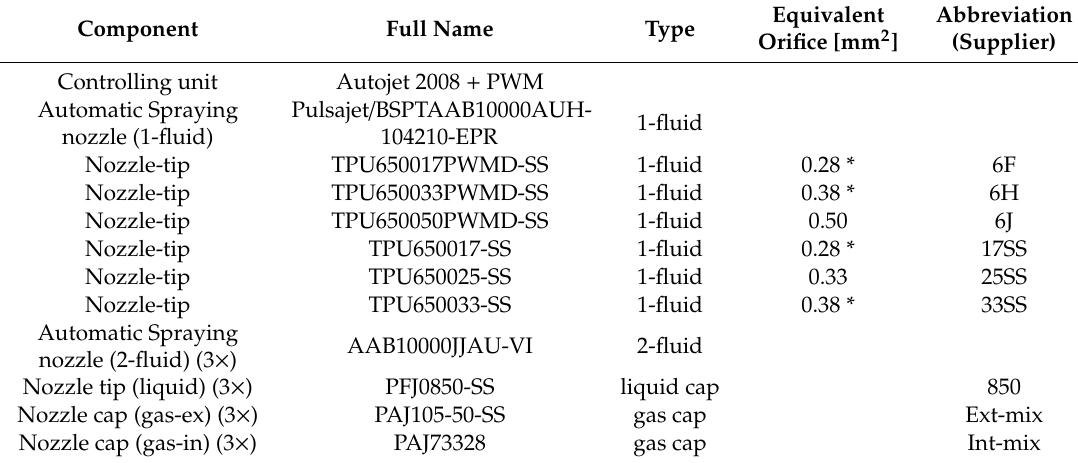
Table 1. Di ff erent spraying nozzles and equipment used in this work. Two nozzles have the same equivalent orifice *. A single 1-fluid nozzle and three equal 2-fluid nozzles in overlapping operation were